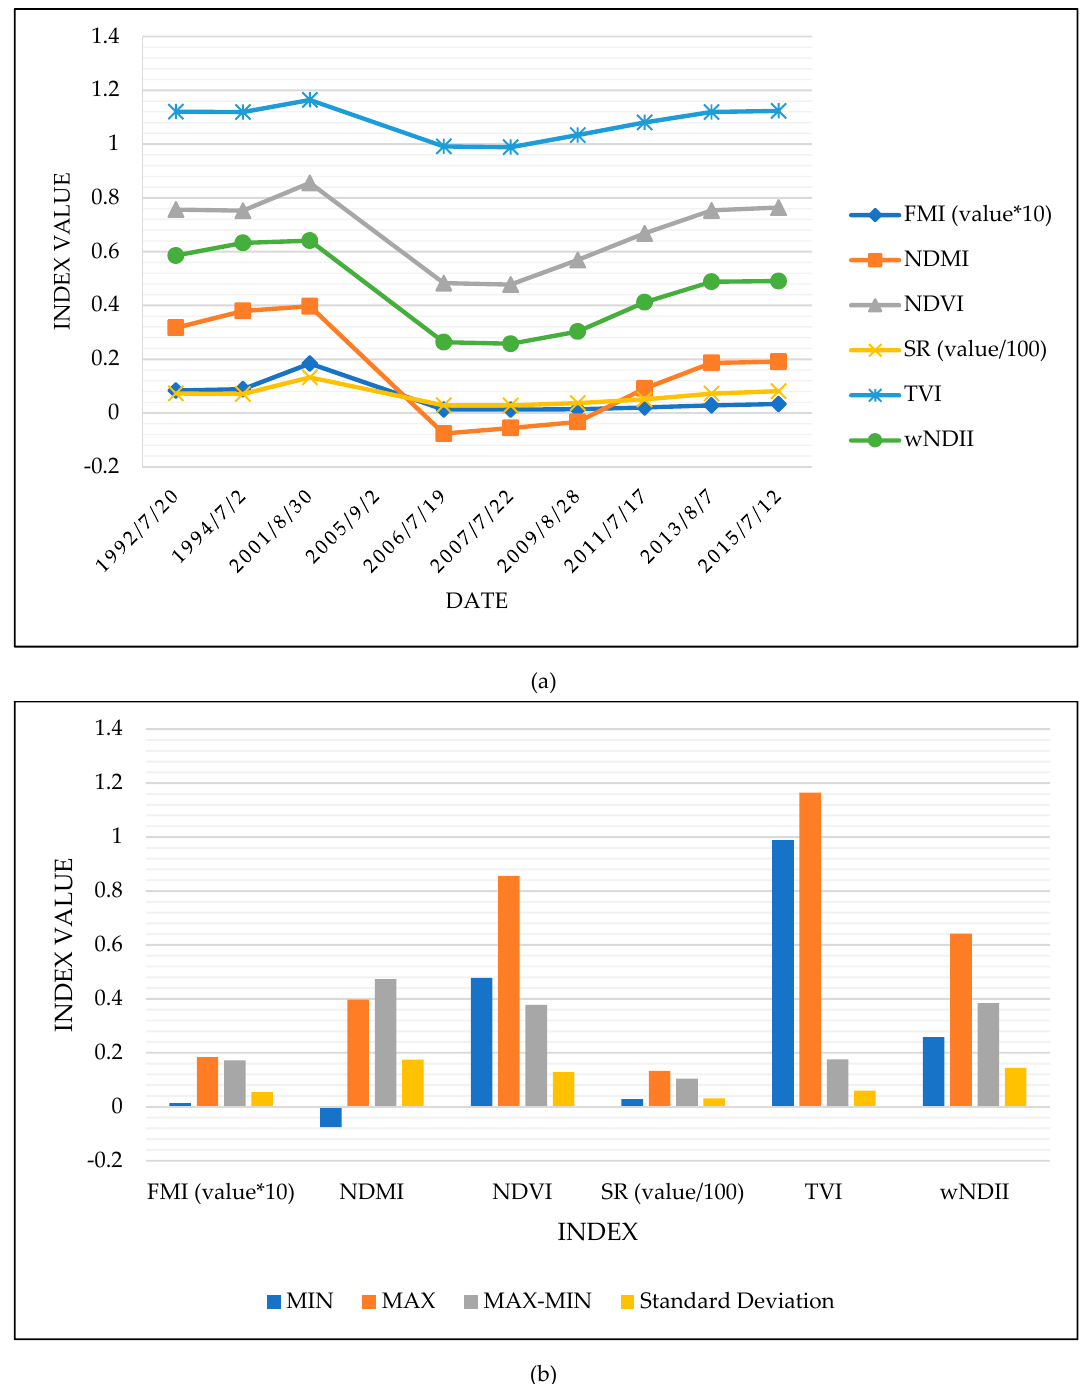
Figure 5. Time series of the vegetation indices for the areas affected by the wind calamity (Locality 1); ( a ) and the statistical information ( b ) (Source: Own work).